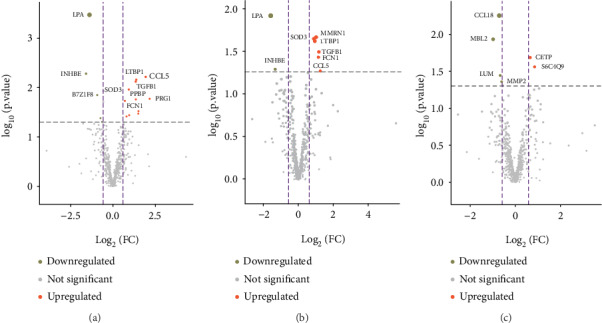
The volcano plots of the differentially expressed proteins between different groups. (a) Type 1 vs. type 2. (b) Type 1 vs. type 3. (c) Type 2 vs. type 3. Downregulated (khaki) and upregulated (orange red) proteins are indicated. Proteins found to be not significantly altered between the groups are displayed in gray. FC: fold change. The top 10 proteins according to their P value ranking are listed. The circle size is proportional to the P value.